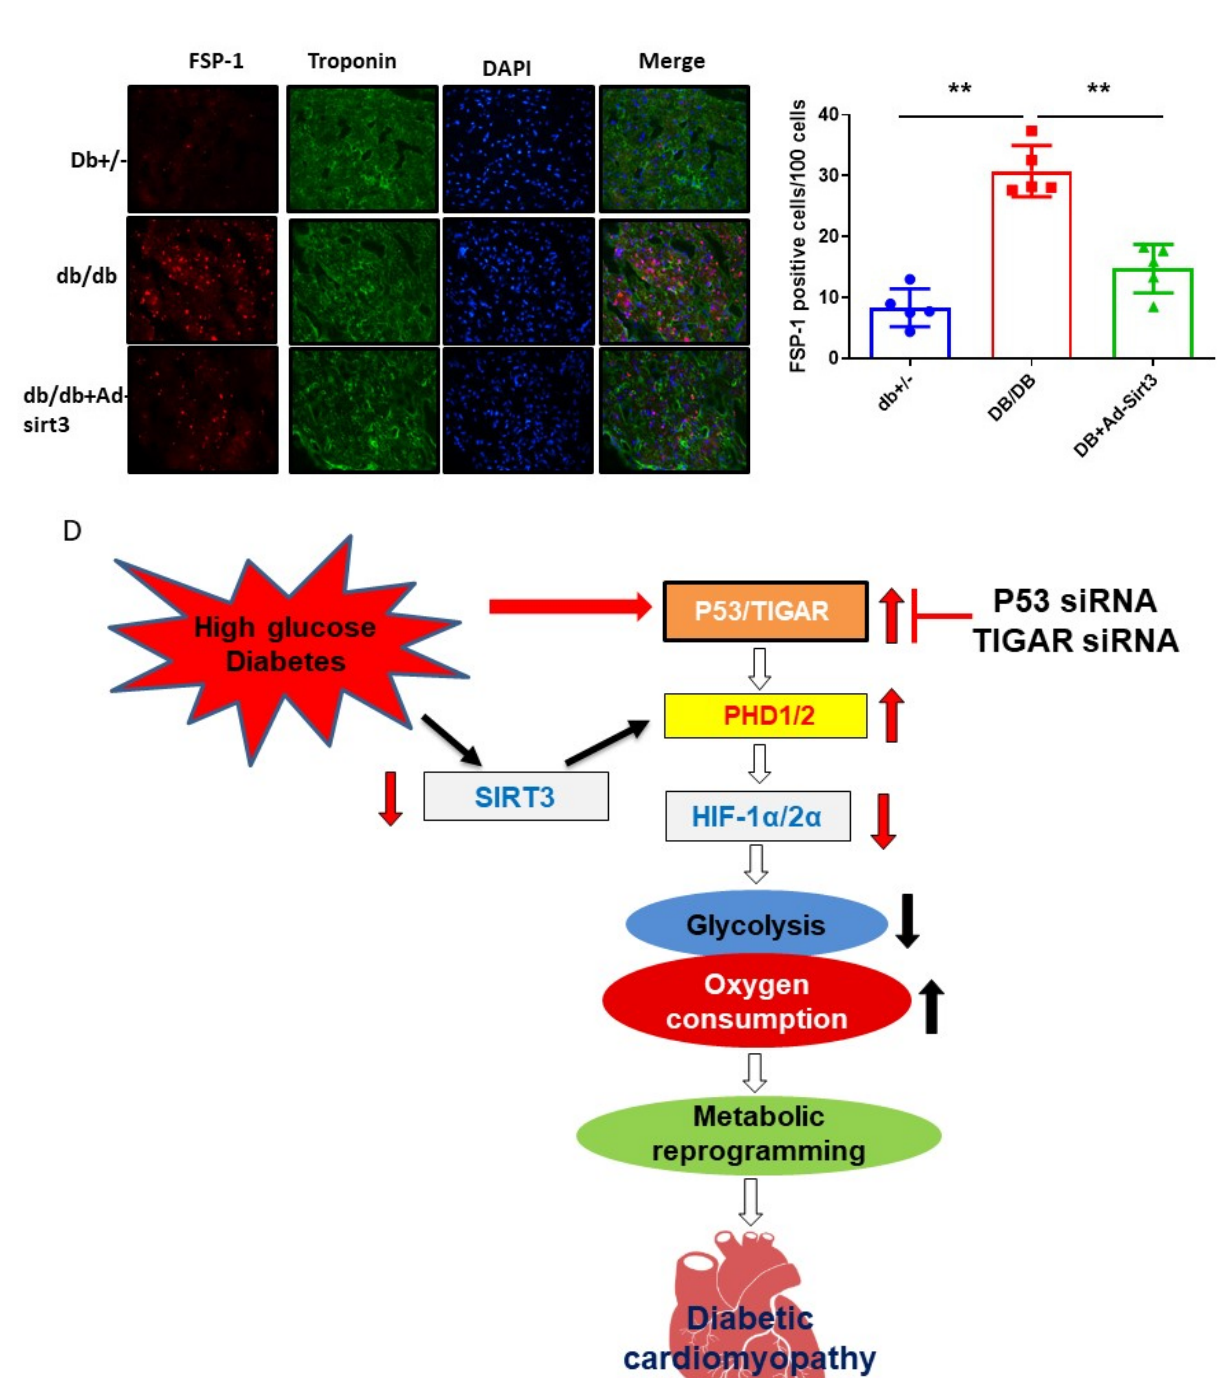
Figure 6. SIRT3 regulates hypoxic signaling in the hearts of diabetic db/db mice. ( A ) Western blot and densitometric analysis demonstrating that expression of PHD1 and PH2 were significantly increased, while treatment with Ad-SIRT3 (1 × 10 9 PFU) significantly reduced the expression of PHD1 and PHD2 in the hearts of diabetic db/db mice. ( B ) Western blot and densitometric analysis showing that the expression of HIF-1 α was signi fi cantly reduced, while treatment with Ad-SIRT3 (1 × 10 9